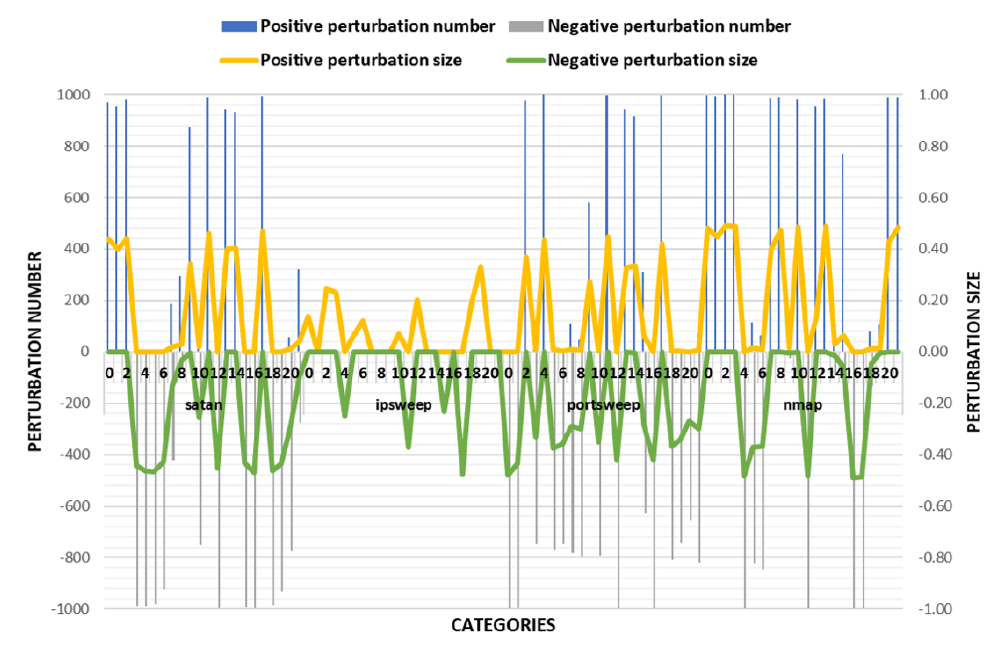
Figure 5. Comparison of the number of perturbation features and the size of the disturbance in TLTD-III.